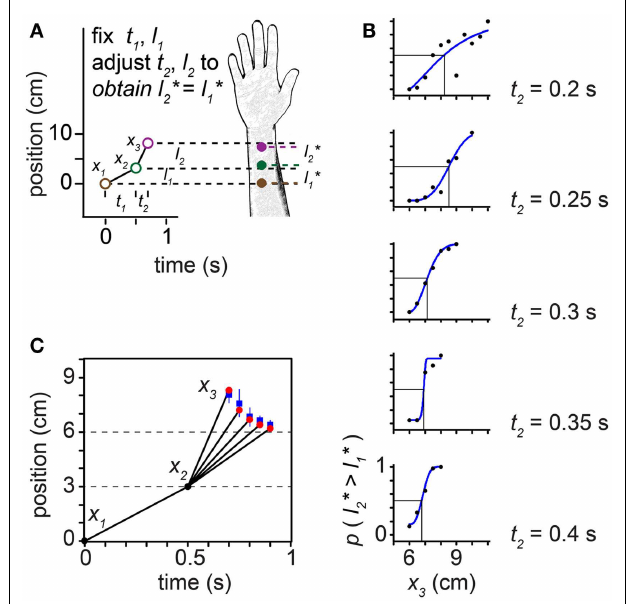
FIGURE 10 |The tau effect . (A) Three taps to the arm, at positions x 1 = 0cm, x 2 = 3cm, and x 3 (variable), define two spatial intervals, l 1 = 3cm and l 2 (variable), and two temporal intervals, t 1 = 0.5s and t 2 (variable). Because t 2 < t 1 , at some l 2 > l 1 the two intervals will be perceived to be of equal length ( l 2 * = l 1 *). (B) At each of five t 2 settings (identified at right of plots), Helson and King (1931) progressively increased l 2 by shifting x 3 along the arm in 0.5-cm increments. On each trial, the participant reported whether the second spatial interval was perceived to be shorter than, equal to, or longer than the first interval.To accurately estimate each participant’s point of subjective equality (PSE), we transformed these data into a two-alternative forced-choice format by distributing the participant’s “equal” responses evenly to the “shorter” and “longer” response categories.We then fit each participant’s transformed data (proportion “ l 2 is longer” responses) at each t 2 setting with aWeibull psychometric function (blue curves). Each psychometric function provides a PSE (vertical line): the x 3 at which the psychometric function intersected 0.5 (horizontal line), indicating that l 2 * = l 1 *.The PSE shifted progressively to the left as t 2 was increased (note: when x 3 = 6cm, l 2 actually does equal l 1 ).The transformed data shown are from one participant (“Observer C”) in Helson and King (1931). (C) Trajectories for which l 2 * = l 1 *. Blue points: mean x 3 that resulted in l 2 * = l 1 * among the six participants tested by Helson and King (1931), at each of the five t 2 settings. Blue lines: ± 1 SD. Red points: best-fit performance of the Bayesian low-speed observer ( τ =